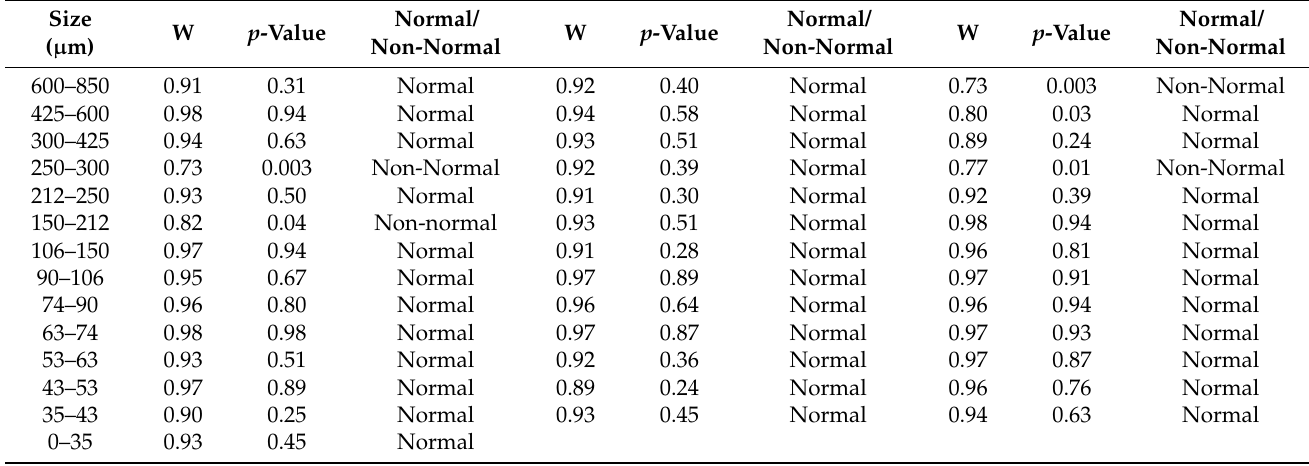
Figure A4. WPES for a second mineral: Top , with the same operating protocol. Middle, with the second operating protocol (145 iron balls distributed in different sizes between 1½”, 1”, and 7/8”, with a total load of 9341 kg; roller at 70 rpm; and 50% solid). Bottom , with the third operating protocol (238 iron balls distributed in different sizes between 1”, 7/8”, ¾”, and ½”, with a total load of 6658 kg; roller at 70 rpm; and 67% solid).